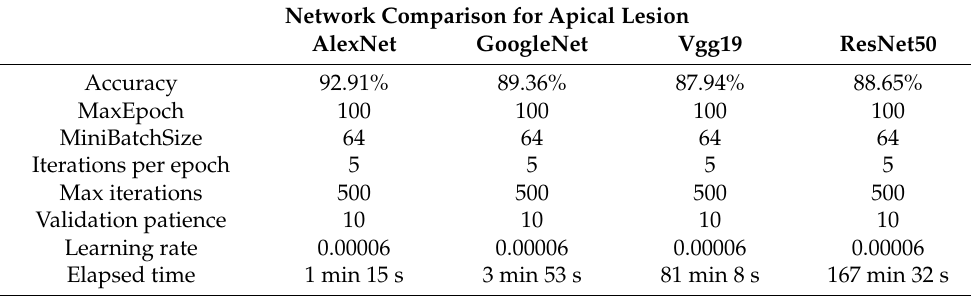
Table 10. Network comparison for apical lesion.